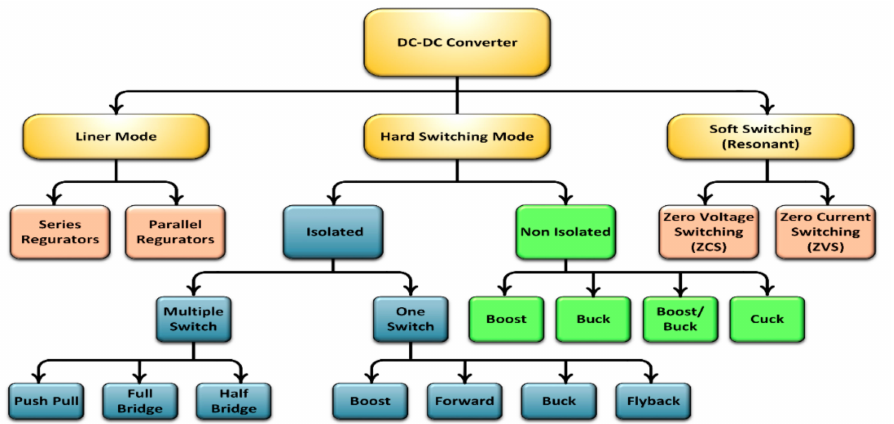
Figure 2. Classification of DC-DC converters